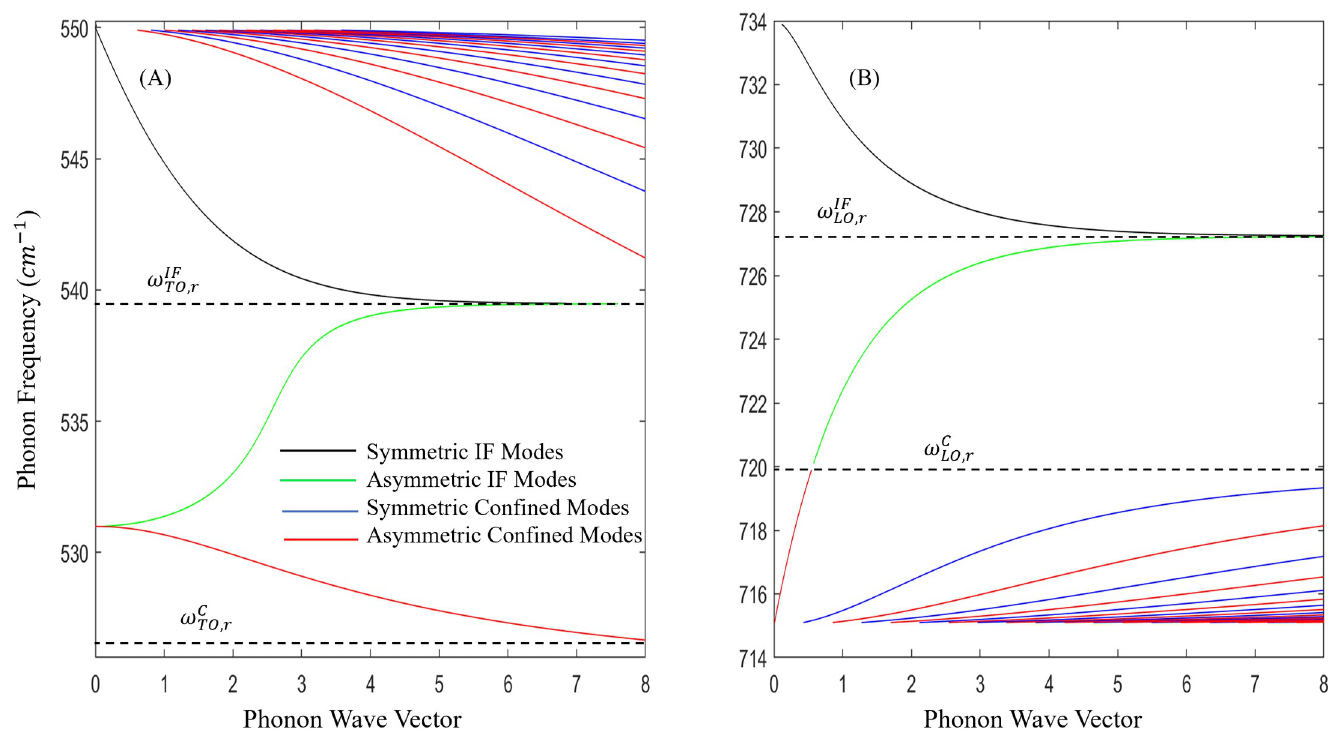
Fig 4. Dispersion relation of frequencies ℏ ω in a wurtzite GaN/In 0.15 Ga 0.85 N/GaN quantum well as a function of free phonon wave number when n = 0. The resonant frequency for IF and confined are indicated by the black dotted lines. The modes depicted are symmetric IF in black, asymmetric IF in green, even confined in blue and odd confined in red. The low-order energy intervals ℏ ω